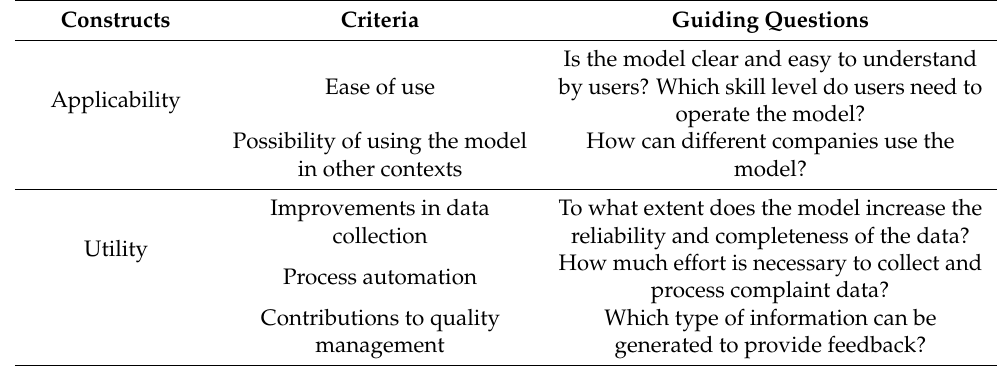
Table 2. Criteria for evaluating the